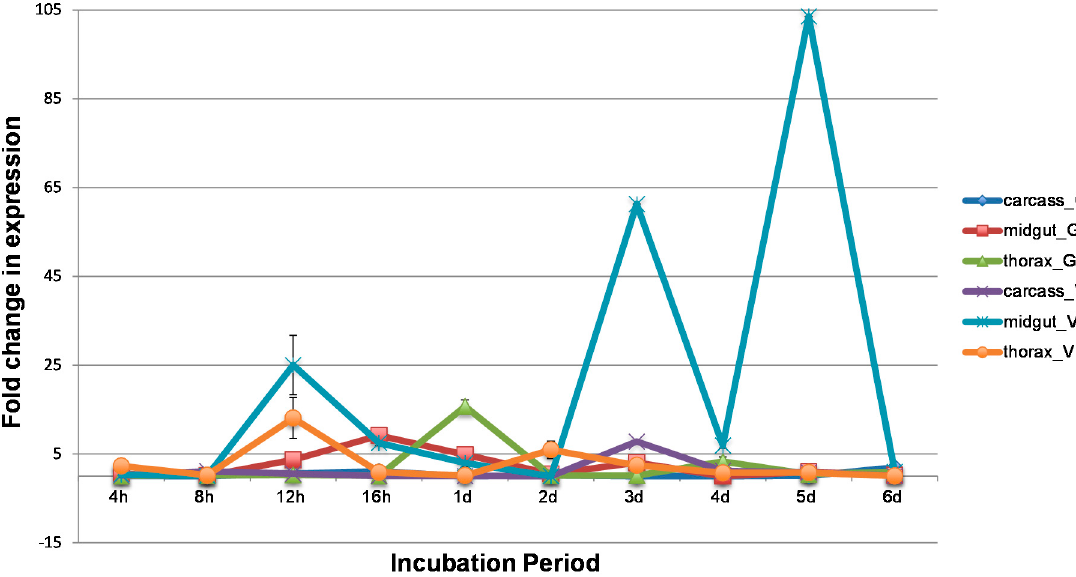
Figure 1. Fold change in CQ G1A1 gene expression in midgut tissue from two populations of Cx. p. quinquefasciatus (CPQG and CPQV) after West Nile virus (WNV) infection. G = CPQG (Gainesville); V = CPQV (Vero Beach); bp, base pairs; h, hours post infection; d, days post infection.